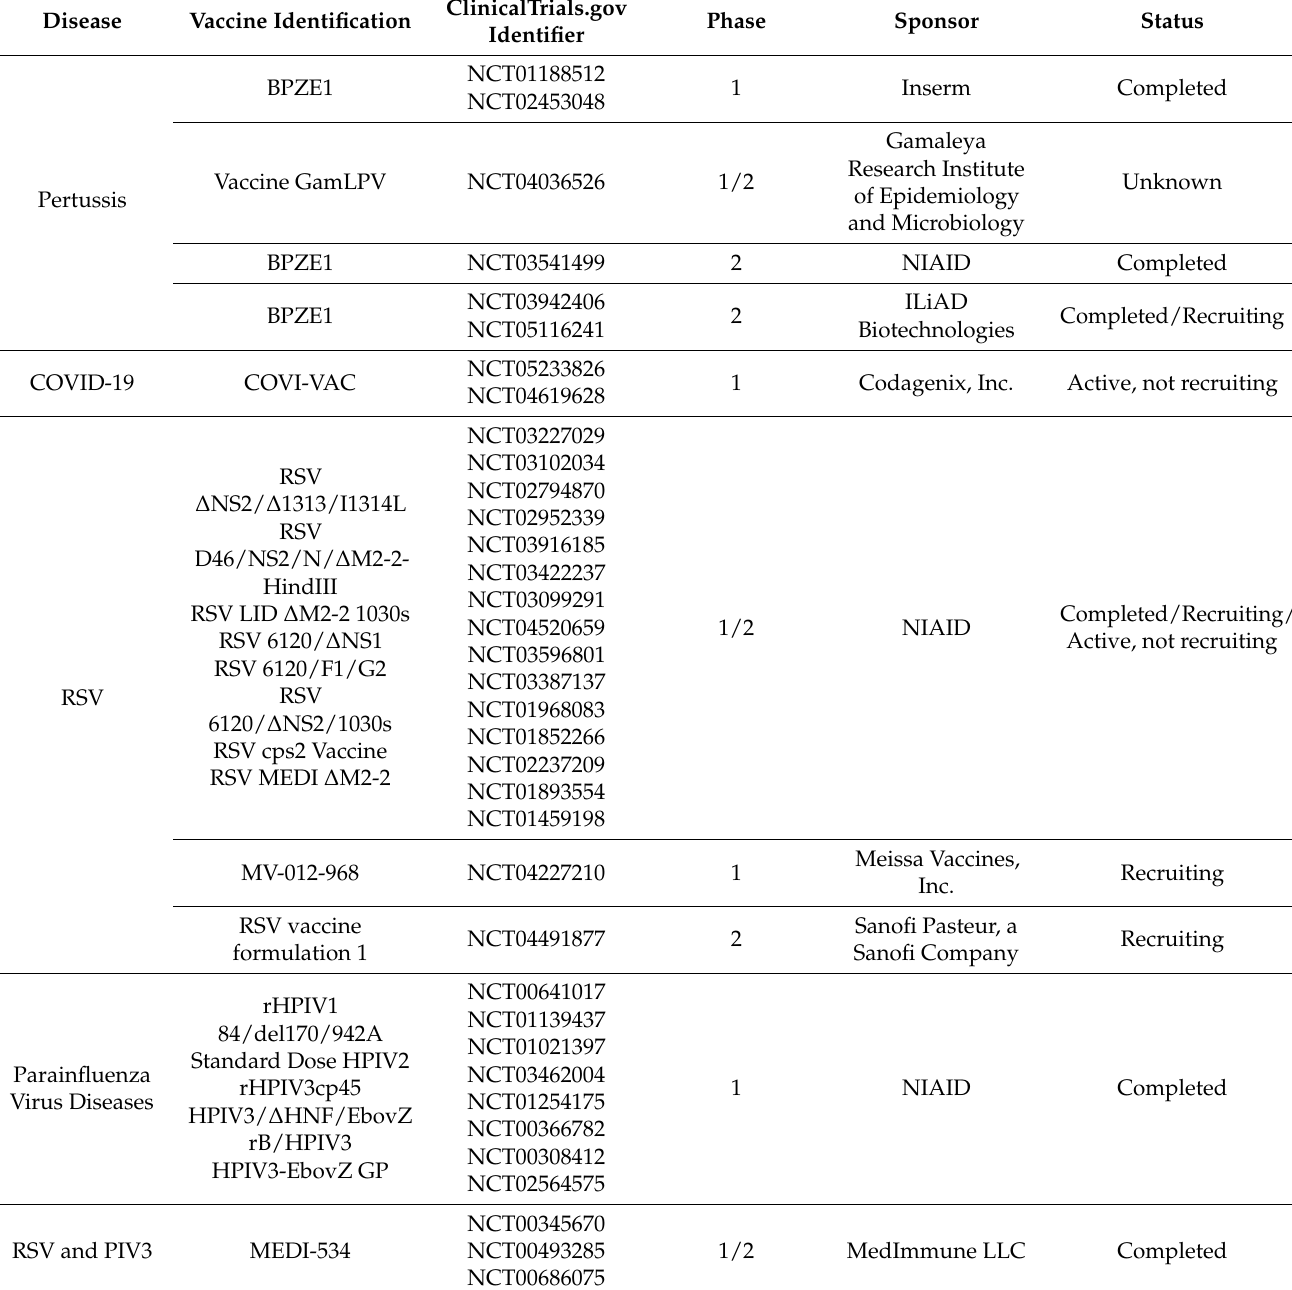
Table 1. The current progress in the clinical development of nasal attenuated